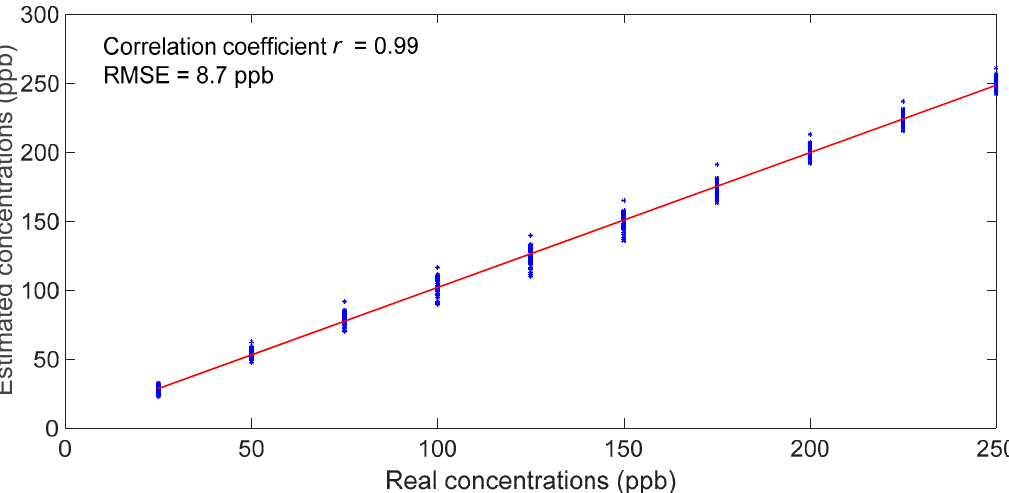
Figure 7. Performance of SVM standardization using 10 samples, illustrated by the predicted concentrations over the real concentrations.